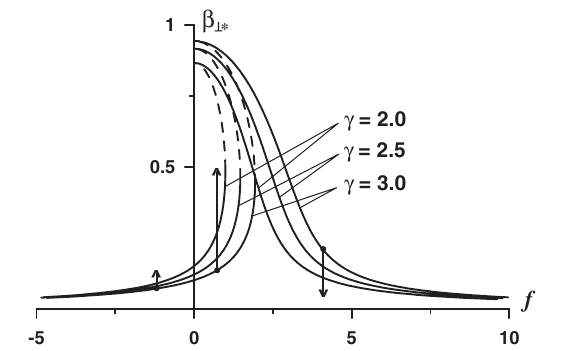
FIG. 9. The transverse velocity at the equilibrium helical tra- jectory for the electrons of different energies versus guide field. The arrows illustrate a change of transverse velocity for decel- erated particles in different regimes.